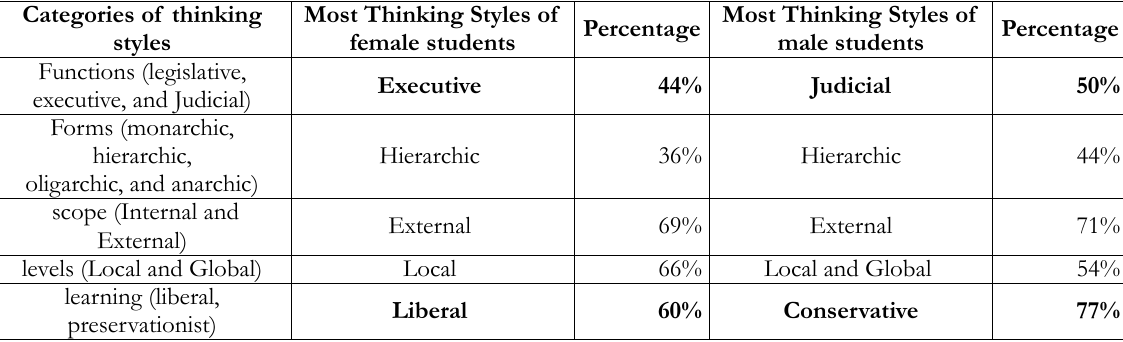
Table 4. Comparison of most thinking styles of between female and male students (different Thinking Style are